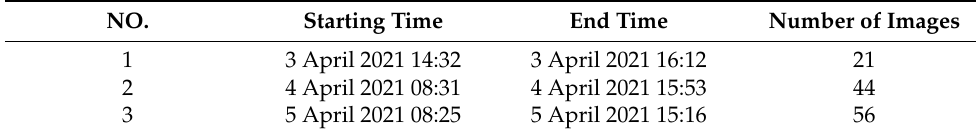
Table 2. Observations from 3 April to 5 April 2021.